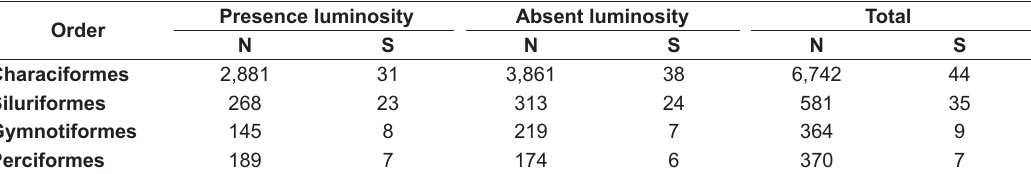
Table 4. Data of numerical abundance (N) and richness (S) for each fish order in periods of presence and absence of luminosity of the nine streams in the Machado river basin, July 2013 to May